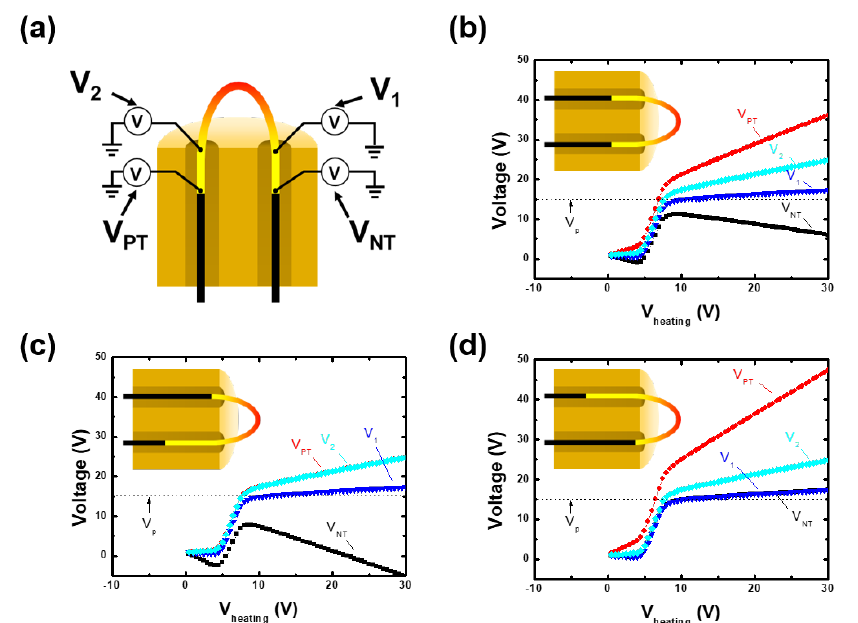
Figure 3. ( a ) Schematic diagram of emissive probe and voltage measurement (V 1 , V 2 , V PT , and